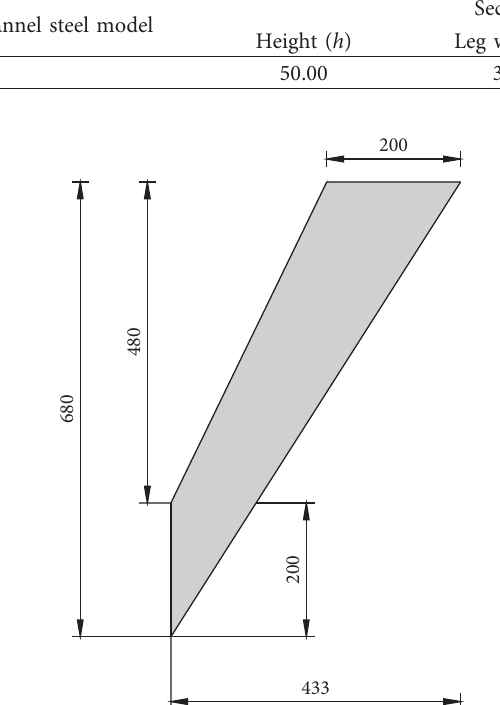
Figure 5: Dimension of the diagonal brace.